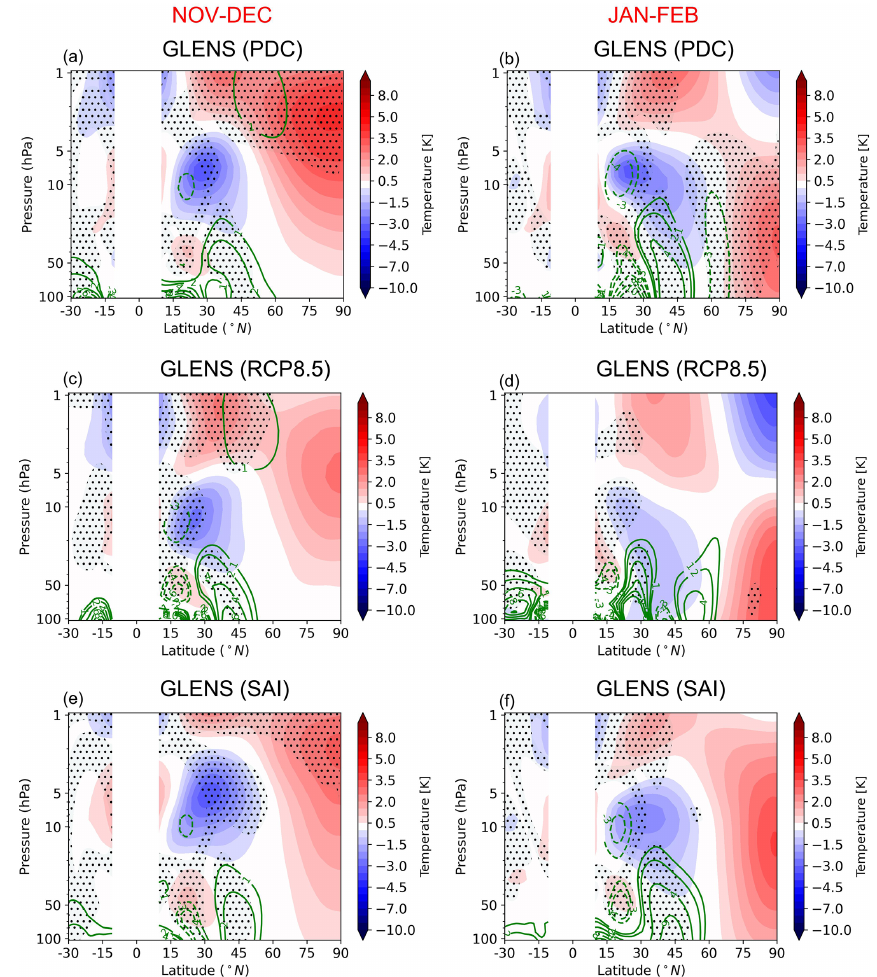
Figure 10. The same as Fig. 9 but for the contribution from the resolved Rossby waves.